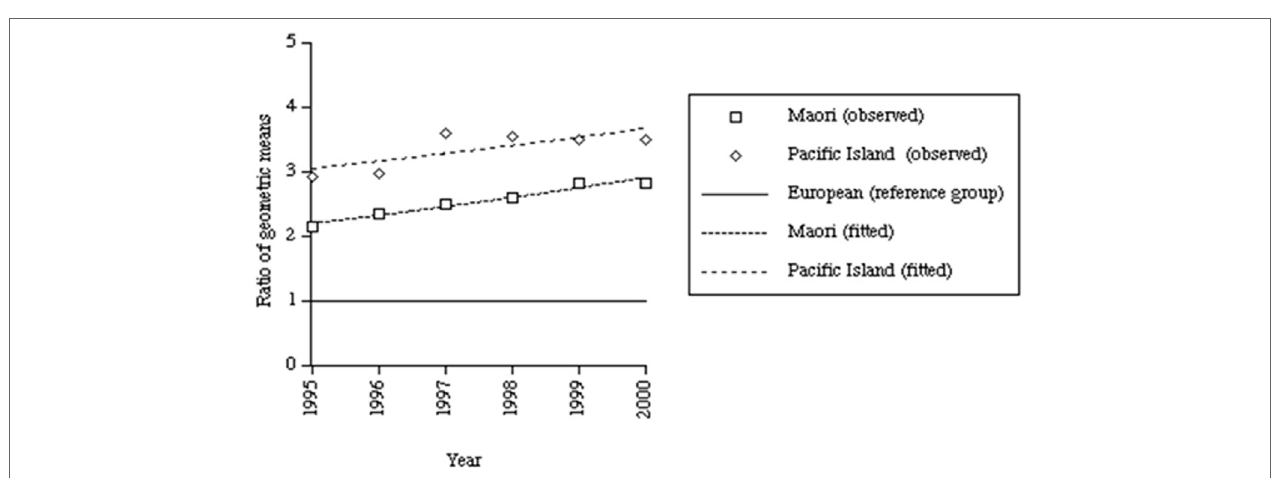
FiguRe 8 | Evidence of widening in ethnic inequalities in deciduous dentition caries experience among Wellington 5-year-olds after the early-1990s social and economic policy “reforms” [from Thomson et al., (110); reproduced with the kind permission of the Australian and New Zealand Journal of Public Health